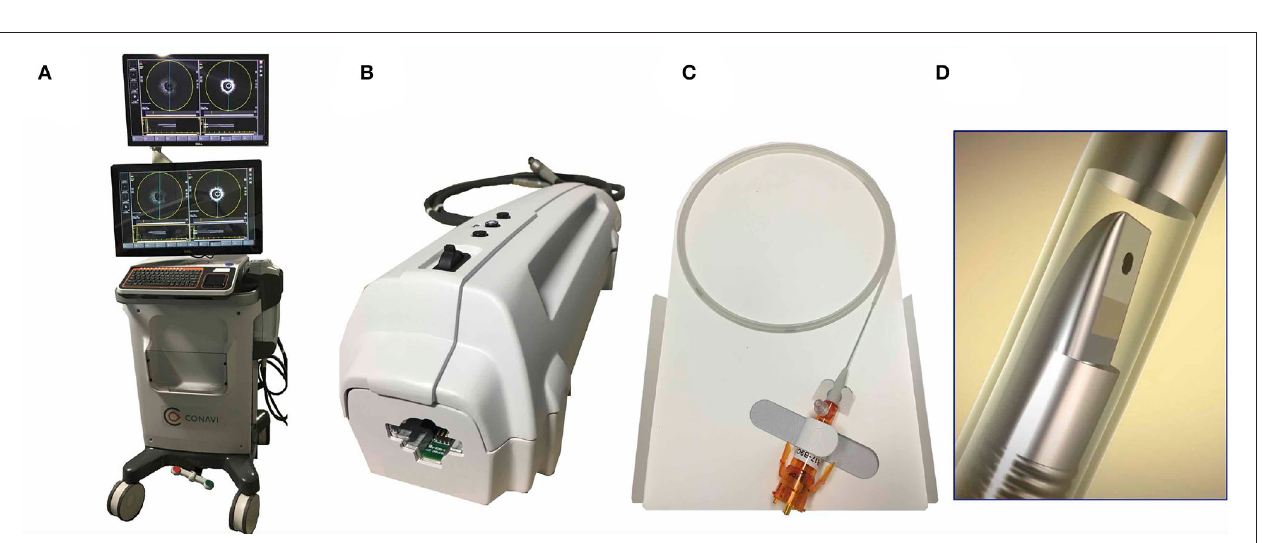
Table 1 . The catheter has a 1.7 Fr. tip and a 2.8 Fr.